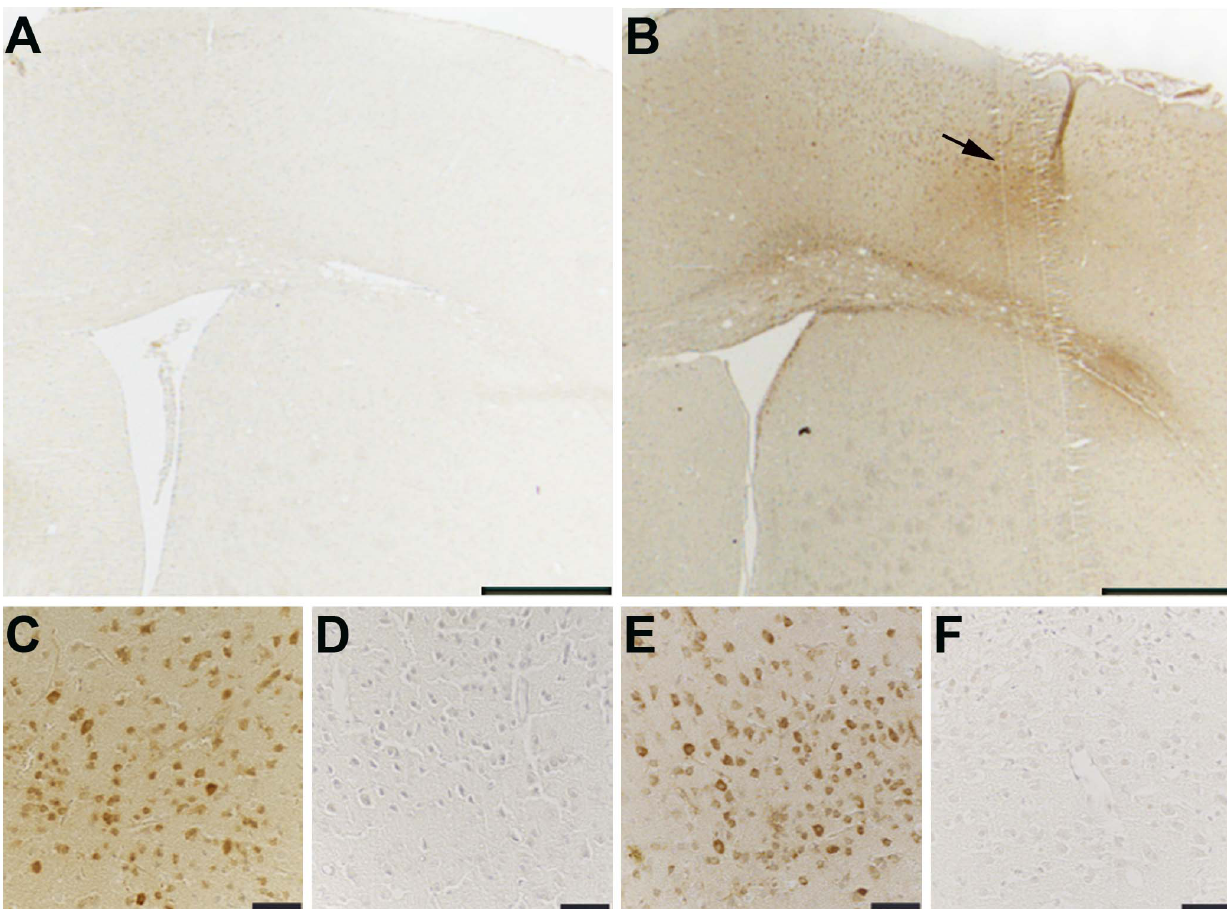
Figure 3. Reduction of CCI-induced pathological tau by mHW in frontal cortex. CCI induced increases in AT8 and Alz50 immunoreactivity extend to the frontal cortex and are attenuated by treatment with hydrogen water. Low power representative images demonstrate increased AT8 immunoreactivity in the frontal cortex of CCI (B) compared to sham treated (A) mice. C–F, high power images of the cortical region shown in B (arrow) demonstrate AT8 (C,D) and Alz50 (E,F) immunoreactivity in CCI (C,E) and HW treated (D,F) mice. Scale bars: 500 m m, A,B; 50 m m, D–F.